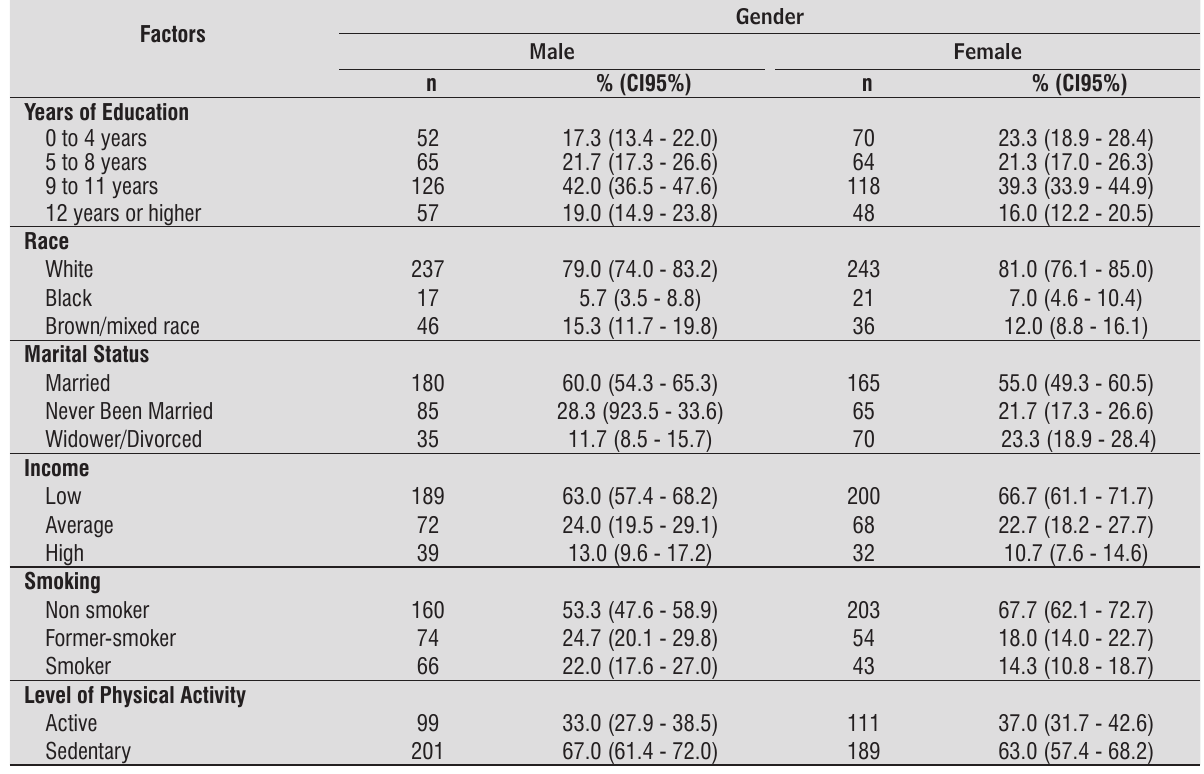
Table 1 - Frequency distribution of the sociodemographic characteristics – level of physical activity and smoking – from the sample with individuals over 20 years old, living in the city of Bauru, by gender Factors